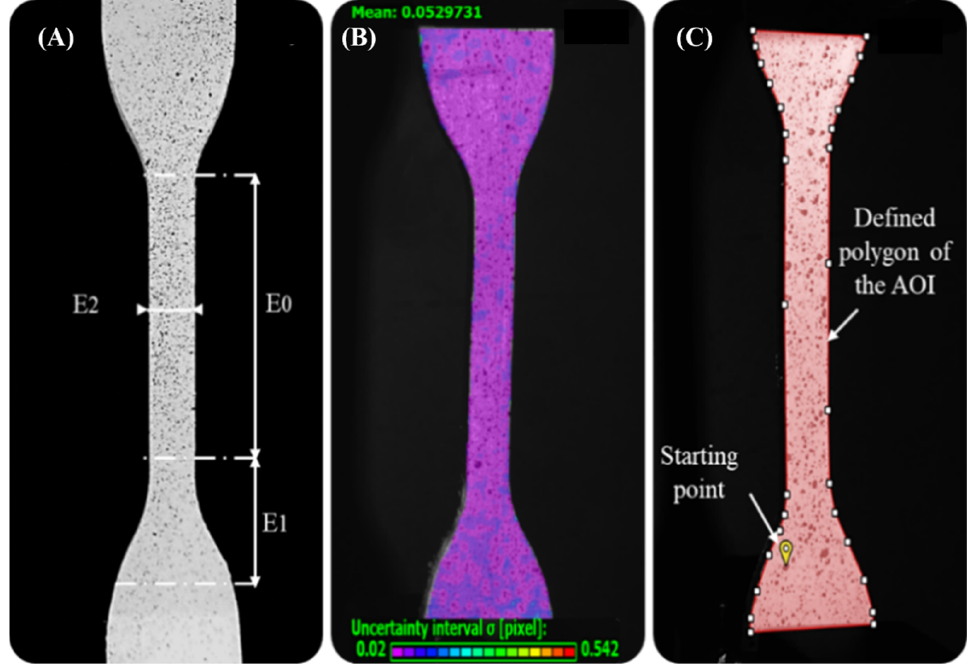
Figure 9. Implementation of the Digital Image Correlation (DIC), main stages. ( A ) Speckle pattern applied on the dog-bone specimen Type IV surface before the tensile test, the defined position of the virtual extensometers E 0 , E 1 , and E 2 are along the XY axes in the regions of interest. ( B ) Image acqui- sition of the specimen, uncertainty range in the correlation of subsets in images; purple: maximum correlation-red: none. ( C ) Post-processing phase. Area of Interest (AOI) on which VIC-3D performs correlation analysis. defined by a polygon on the specimen surface image. Likewise, the starting point is evidenced placed in the area of the image that is subjected to the least amount of movement (grip attachment) during the tensile